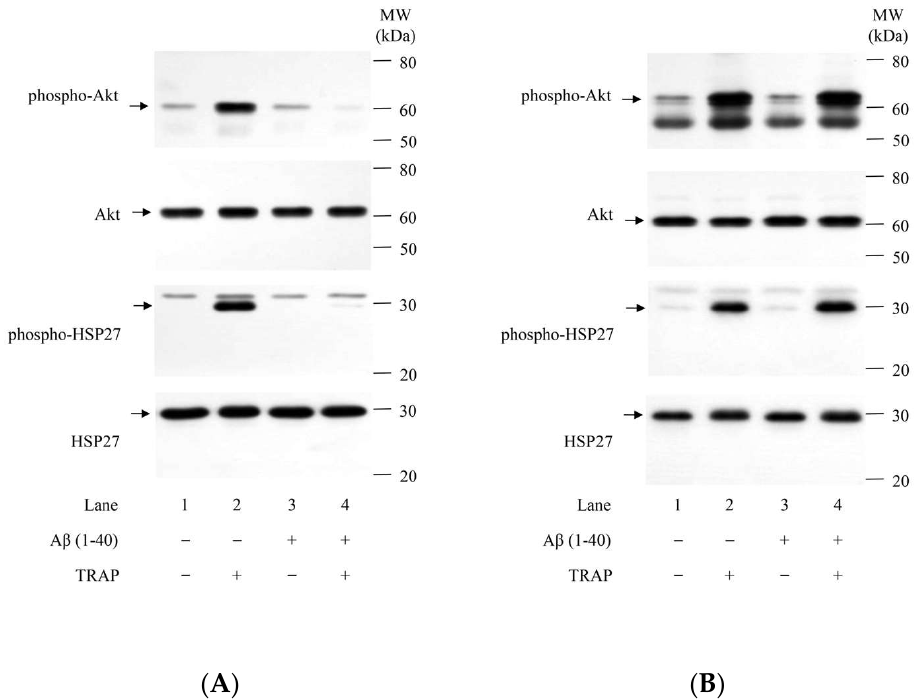
Figure 2. Effects of A β (1–40) on TRAP-induced phosphorylation of Akt, and HSP27 in human platelets of DM patients. PRP was pretreated with 10 µ M of A β (1–40) or vehicle at 37 ◦ C for 15 min and then stimulated with 8–15 µ M of TRAP or vehicle for 5 min. The dose of TRAP achieving a transmittance of 70–100% recorded using a PA-200 aggregometer was adjusted individually. The reaction was terminated by the addition of an ice-cold EDTA solution. The lysed platelets were then subjected to Western blot analysis using antibodies against phospho-specific Akt (Thr-308) and Akt and phospho-specific HSP27 (Ser-78) and HSP27. The representative results of two different responsiveness to A β , suppressed ( A ) and unchanged ( B ), are presented, respectively. The data from identical samples of Figure 1 are shown. Phospho-specific Akt (Thr-308) antibodies and Akt antibodies were purchased from Cell Signaling Technology, Inc. (Beverly, MA, USA). Phospho-specific HSP27 (Ser-78) antibodies was purchased from Enzo Life Science, Inc. (Plymouth Meeting, PA, USA). HSP27 antibodies were purchased from Santa Cruz Biotechnology, Inc. (Santa Cruz, CA, USA).